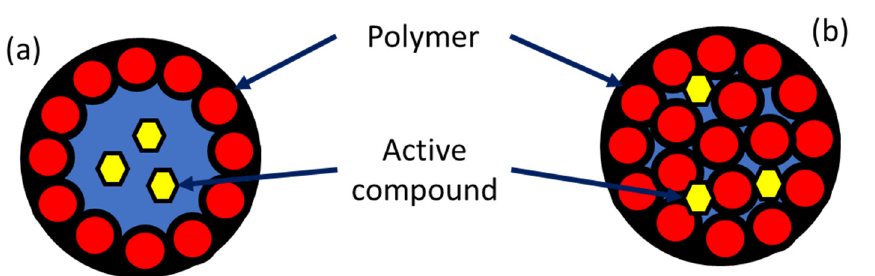
Figure 4. Nanoparticle structures: nanocapsule ( a ), nanosphere ( b